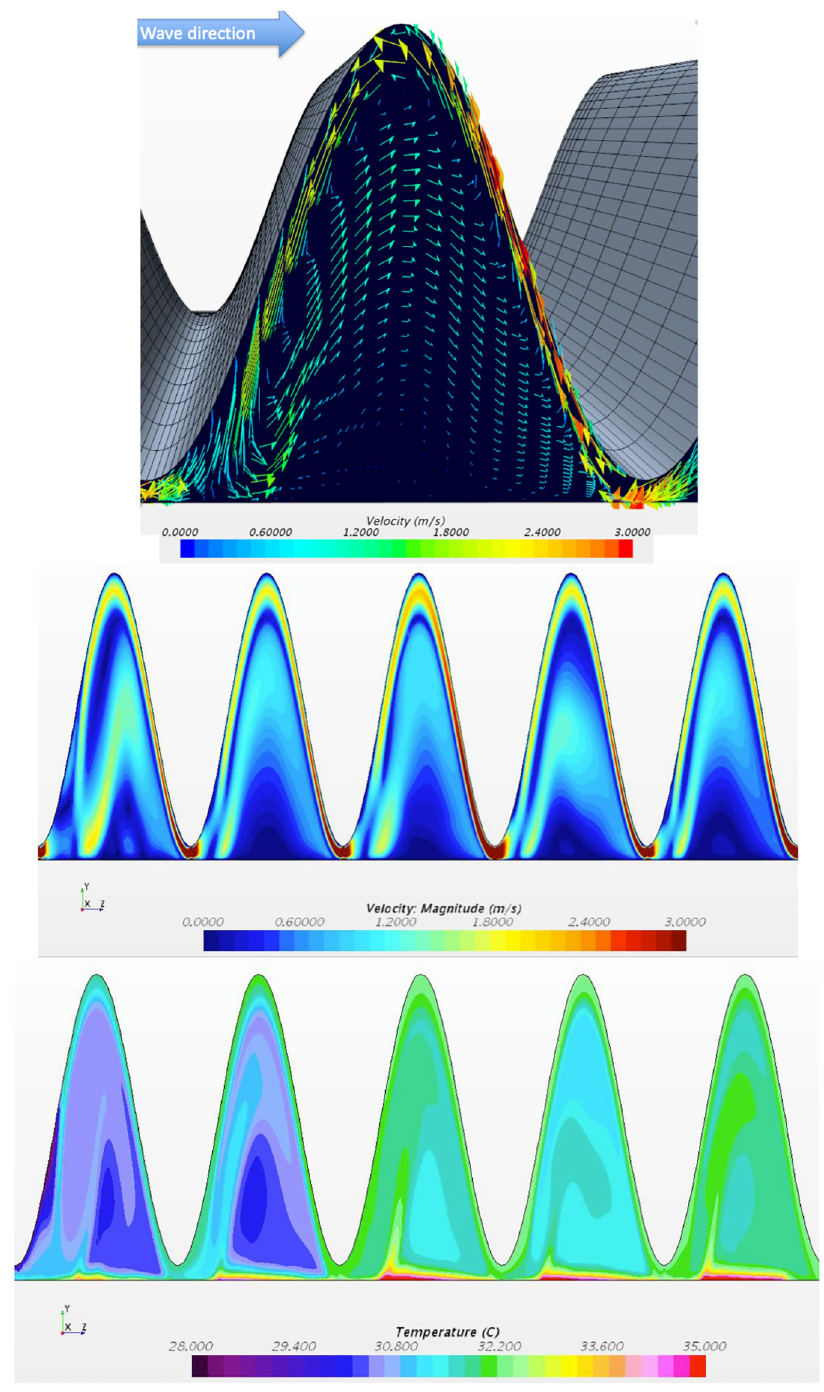
Fig 3. Local analysis. Instantaneous fields: (a) velocity field in a given corrugation, (b) velocity and (c) temperature fields in the symmetry plane. Δ P = − 50 Pa , f = 50 Hz and A = 90%. s r